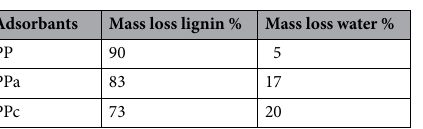
Table 2. Inverse relation between water contents and adsorbed lignin